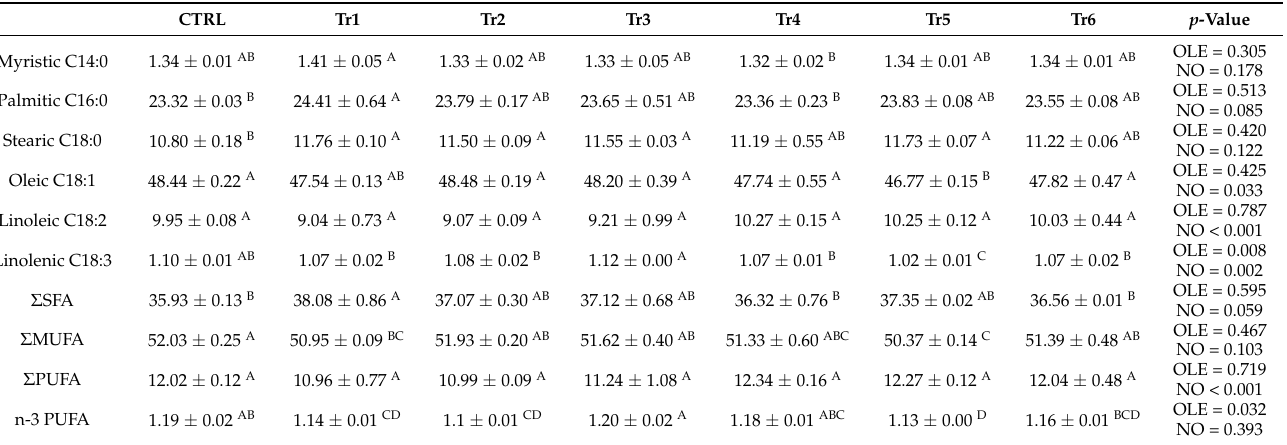
Table 7. Mean value, standard deviation, and results of statistical analysis of the main fatty acids of the lipid fraction of the ripened sausages ( n =